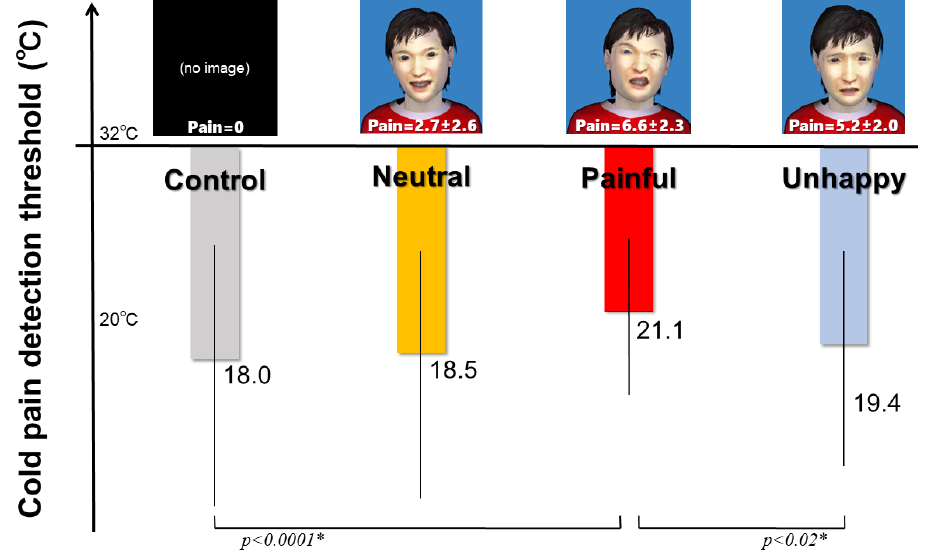
Figure 1. Cold Pain Detection Thresholds while Watchng Three Different Facial Expressions of a Virtual Agent and a Black Screen. Average cold pain detection thresholds (squares) of the participants while watching three different facial expressions of a virtual agent and a black screen are shown. Error bars indicate standard deviations of the respective cold pain detection thresholds for the facial expressions. For the three facial expressions, participants mandatorily rated pain intensity on an 11-point numerical rating scale. Differences between the average default cold pain detection threshold of all participants and their cold pain detection thresholds while watching a black screen and the three facial expressions were compared using analysis of covariance (ANCOVA) with the respective pain intensities as covariates. Only when watching the painful expression of a virtual agent did the cold pain detection thresholds increase significantly. * Adjusted by pain intensities for facial expressions.